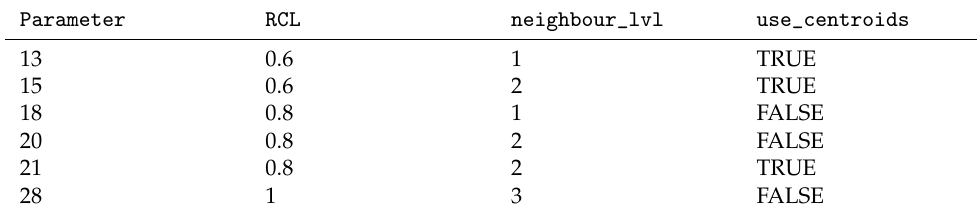
Table 5. Top 10 ranked parameters values.